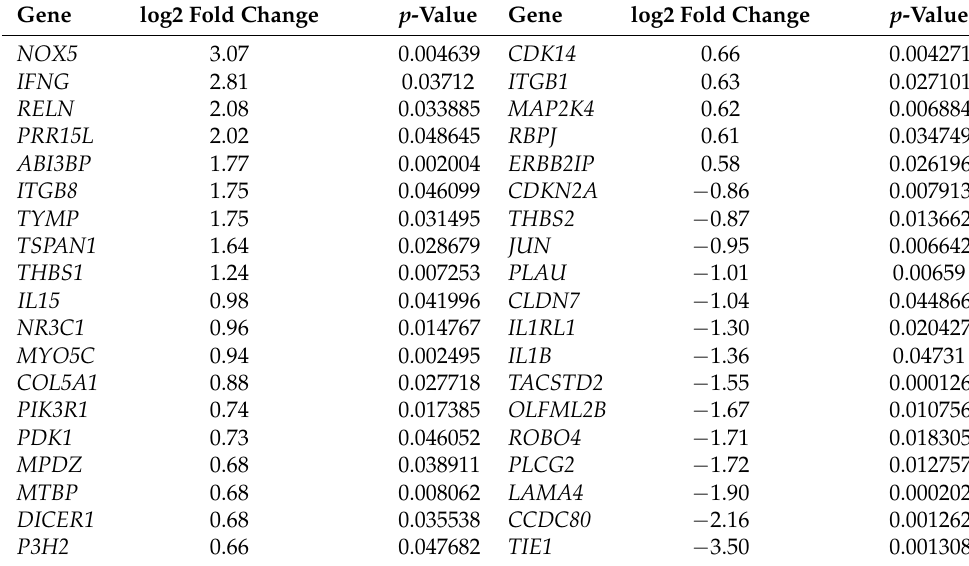
Table 2. Genes deregulated in EV C-treated versus untreated PC3MLs.